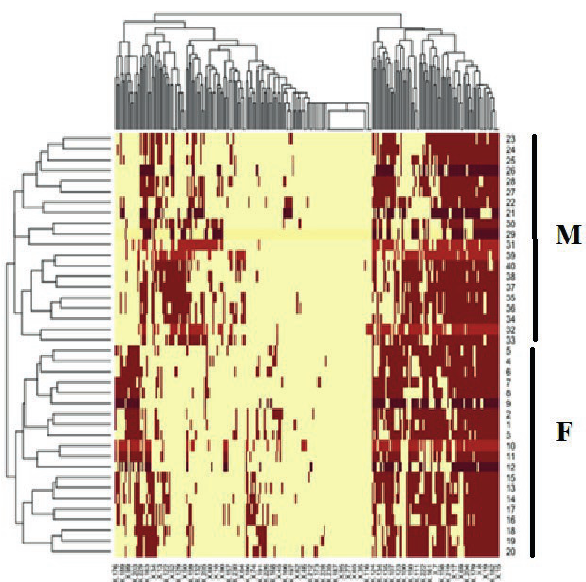
Figue 4. Heatmap cluster based on 30 molecular loci and male (M) and female (F) date palm trees